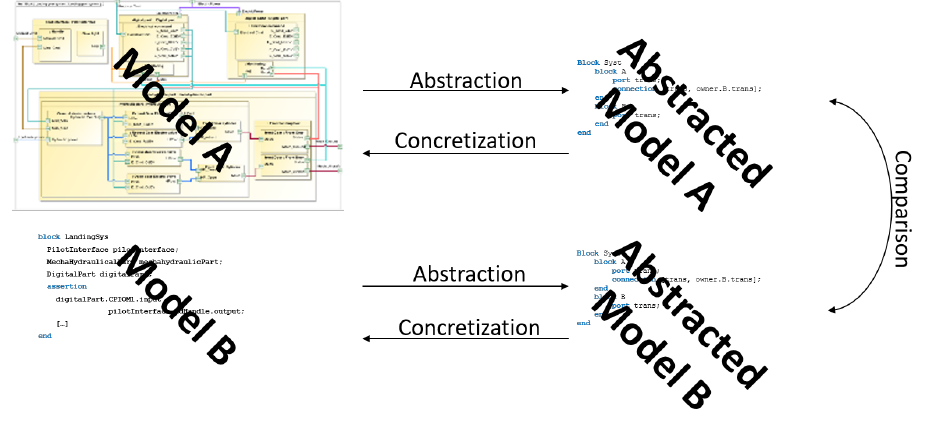
Figure 1. Model synchronisation